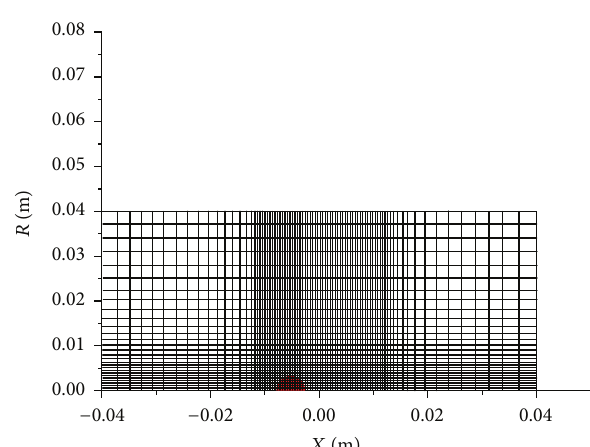
Figure 4: Pressure pulse profile in the calculation.